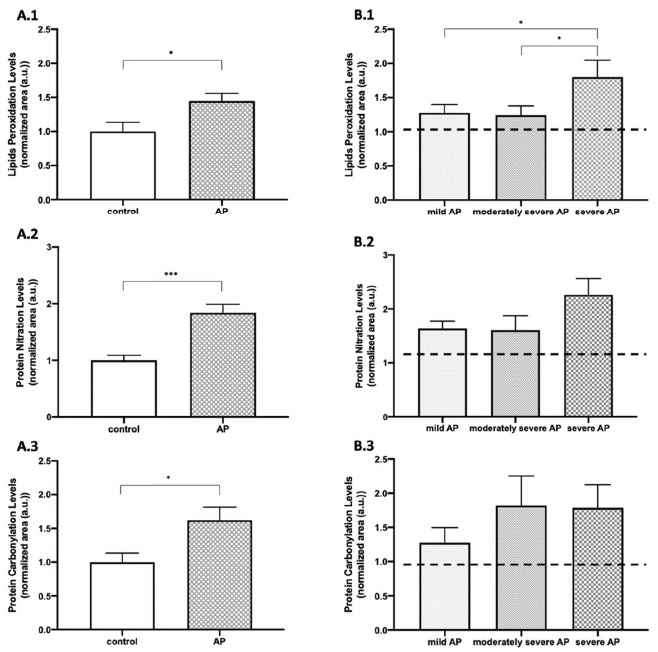
Figure 2. Plasma levels of OS-related markers of acute pancreatitis (AP) and healthy control groups. ( A.1 ) 4-HNE (lipid peroxidation), ( A.2 ) 3-NO (protein nitration), ( A.3 ) DNP (protein carbonylation) in the control group and biliary AP patients. ( B.1 ) 4-HNE (lipid peroxidation), ( B.2 ) 3-NO (protein nitration), ( B.3 ) DNP (protein carbonylation) in the different degrees of biliary AP severity on admission. AP: acute pancreatitis; 3-NO: 3-nitrotyrosine; 4-HNE: 4-hydroxynonenal; DNP: 2,4- dinitrophenyl-hydrazone. Results are expressed as mean ± SEM. The differences versus control are marked by *, where * represents p < 0.05 and *** p < 0.001. Mann–Whitney test: ( A.1 – A.3 ). Comparison of Fisher’s least significant difference post hoc test: ( B.1 – B.3